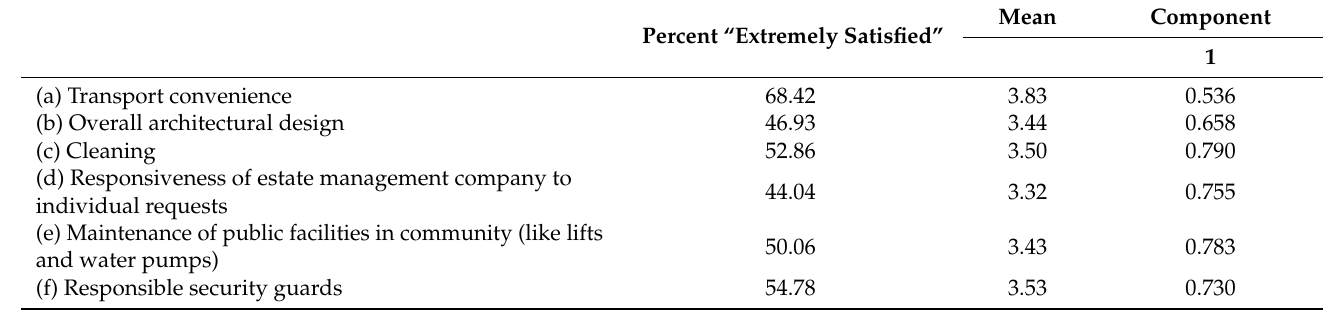
Table 2. Principal components analysis of community environment